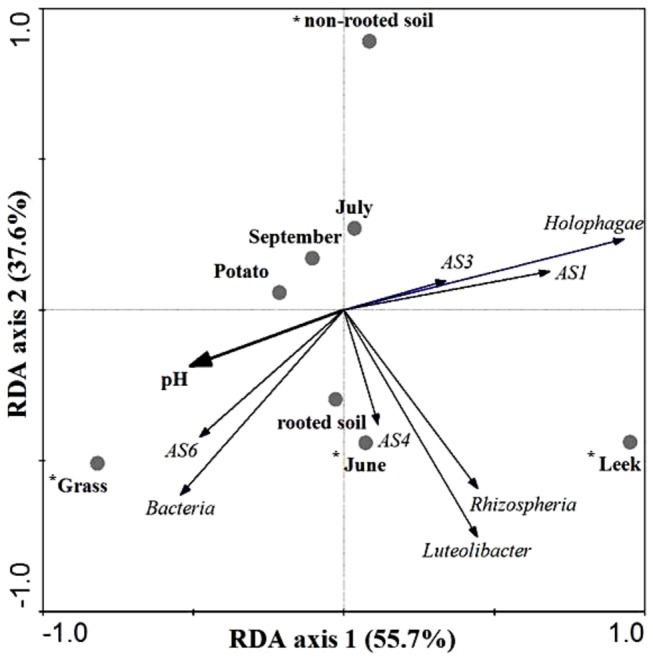
Biplot diagram calculated by redundancy analysis (RDA) on total bacteria, Luteolibacter and Candidatus genus Rhizospheria and of subdivisions 1, 3, 4 and 6 acidobacteria and holophaga as species, and location in soil, plant species, sampling time and soil pH as environmental variables.Environmental factors marked with * have significant effects on species variables at a significance level of P = 0.002.